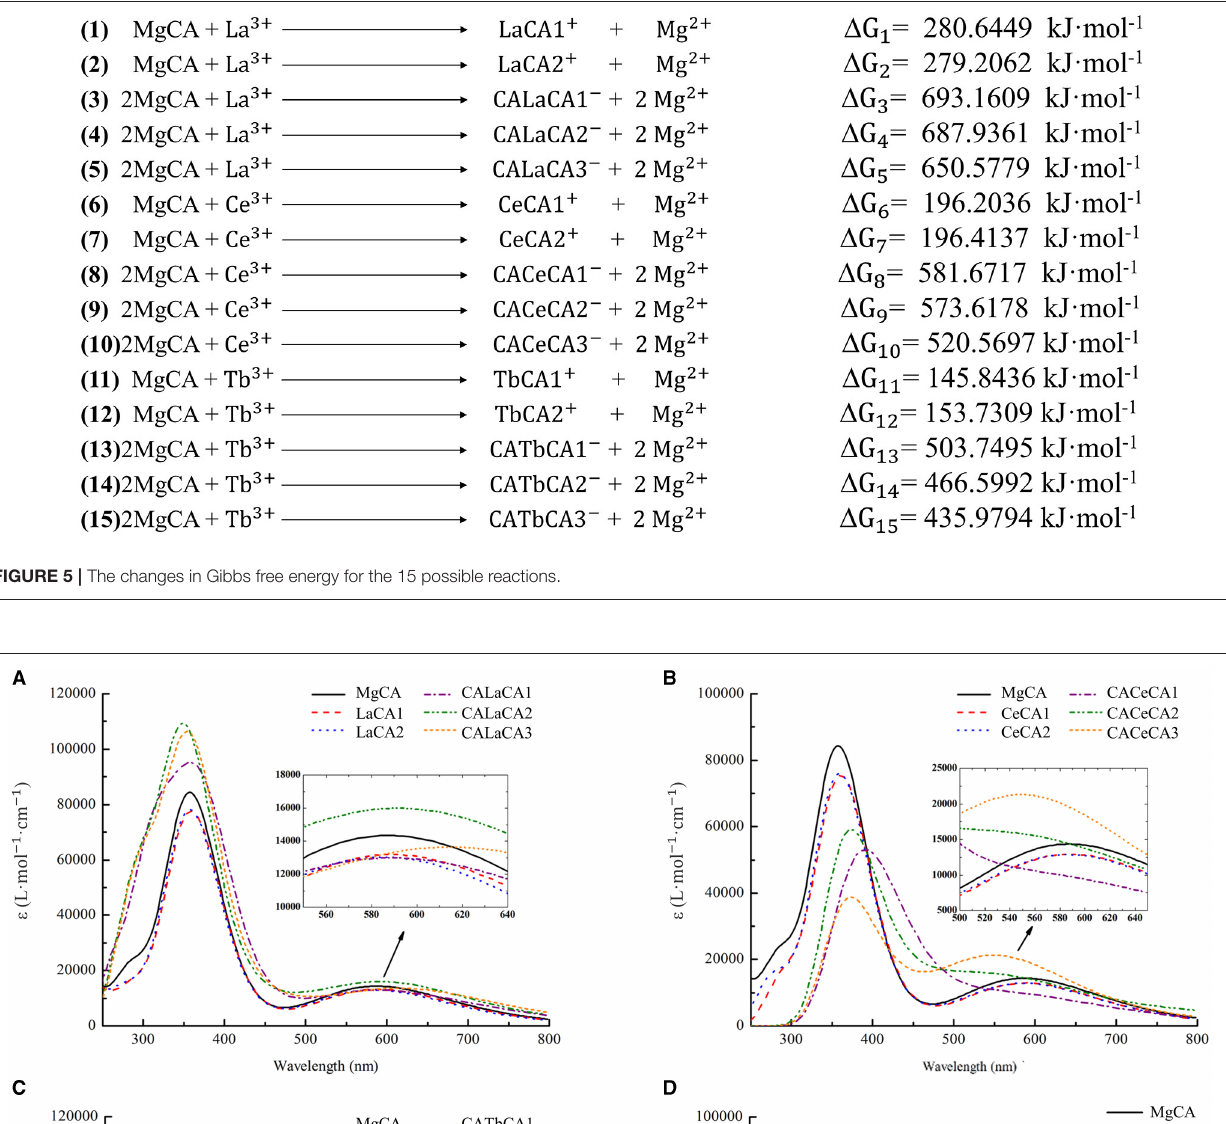
Frontiers in Plant Science |